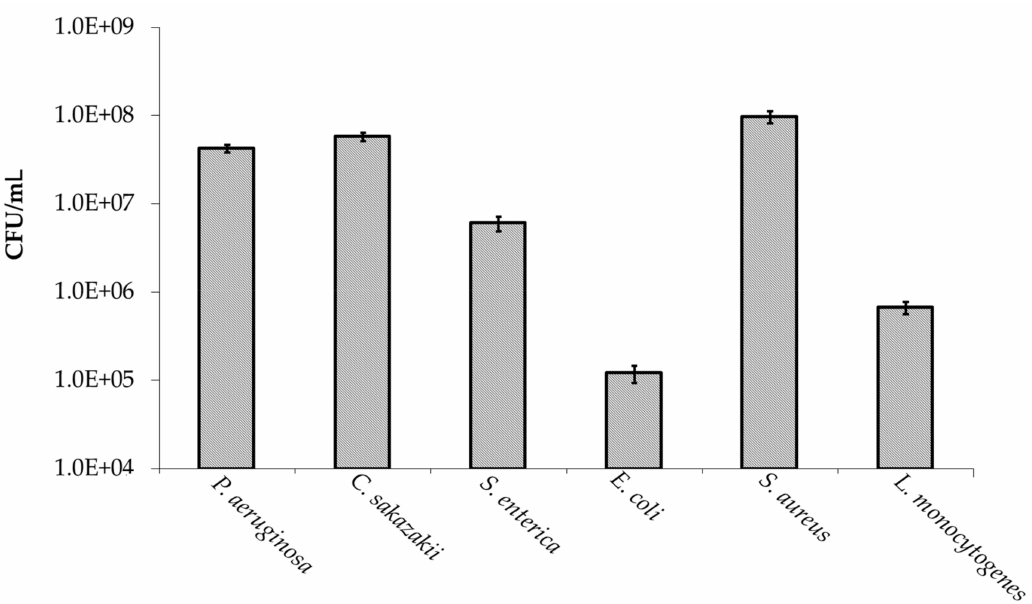
Figure 2. Adhesion of pathogenic bacteria to the human colonic adenocarcinoma cell line, HT-29.